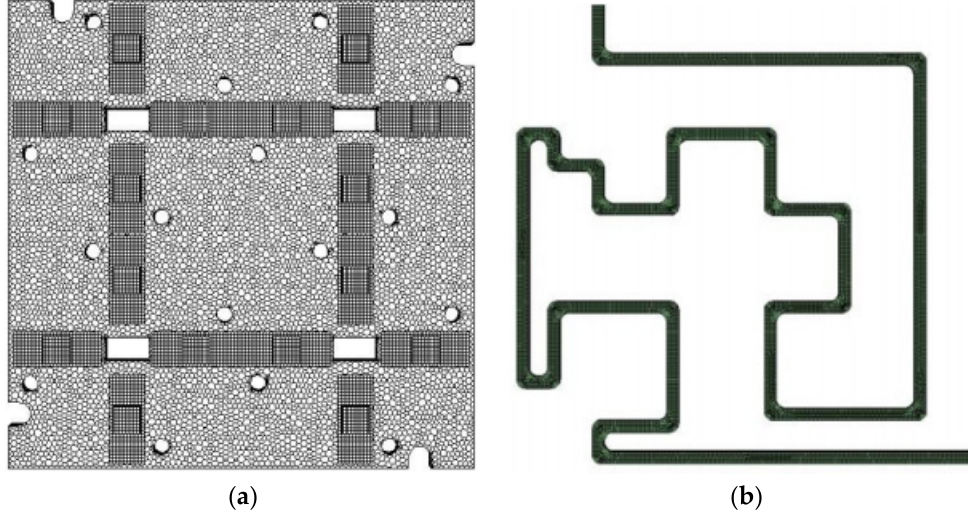
Figure 5. The grid model of ( a ) solid domain; ( b ) fluid domain.